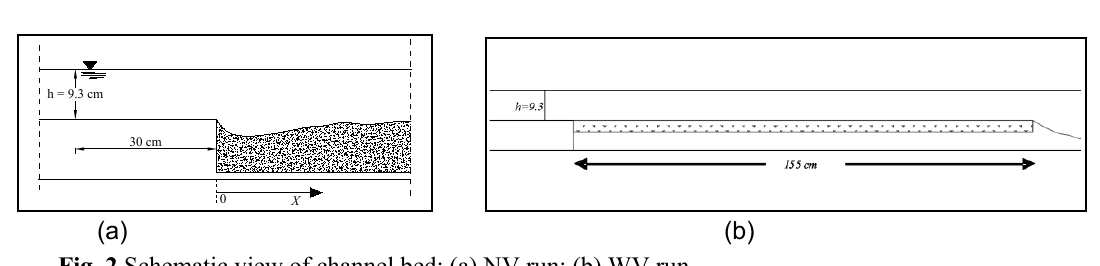
Fig. 2 Schematic view of channel bed: (a) NV run; (b) WV run.